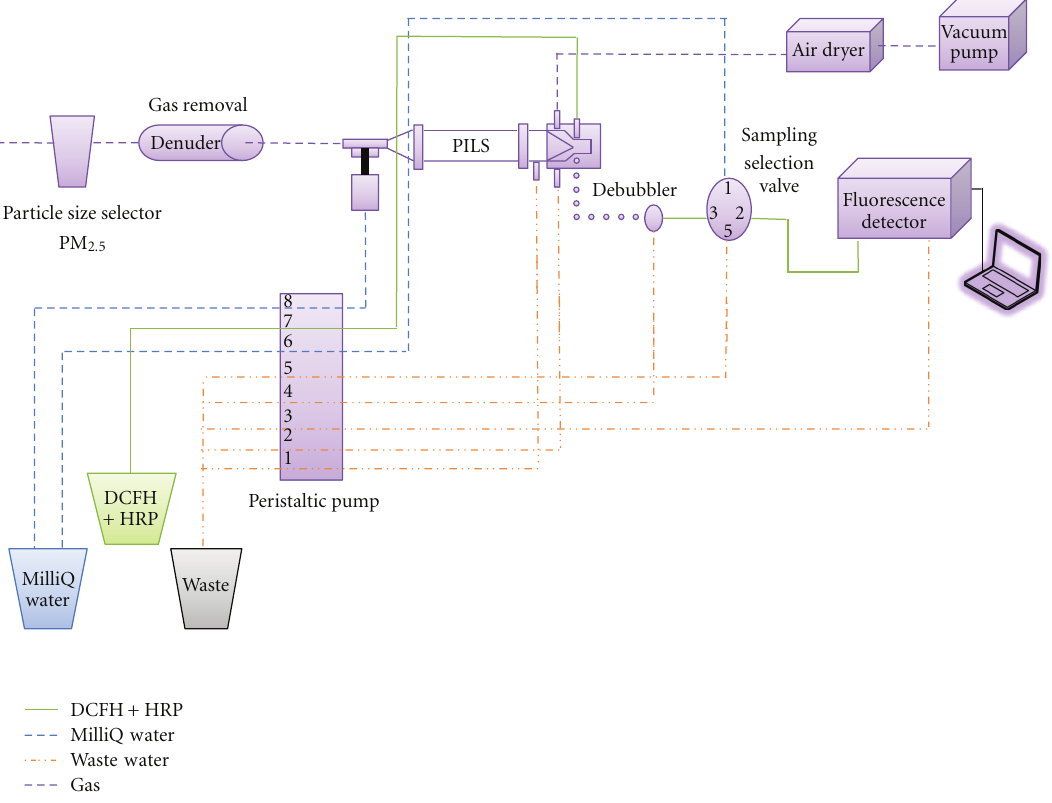
Figure 1: Schematic diagram of the particle-bound ROS automated